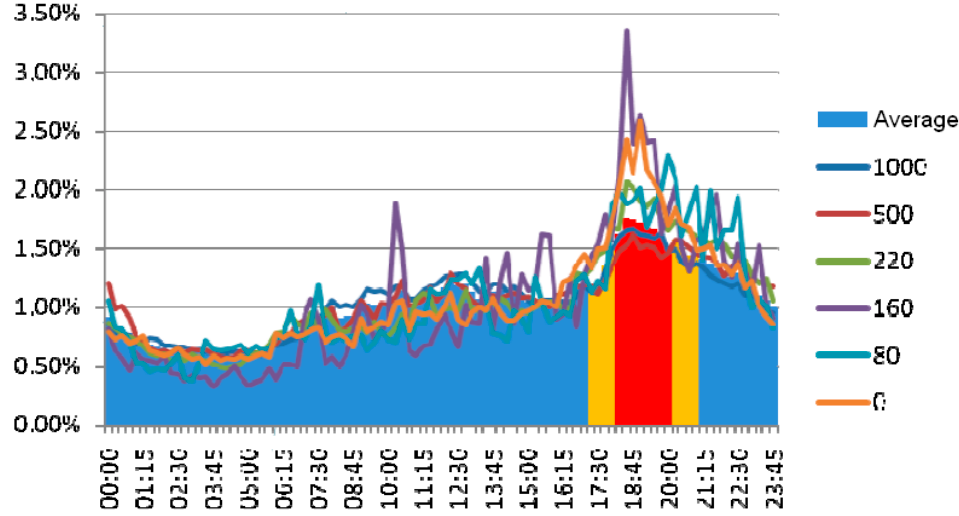
Figure 3. Charge curve of a typical residential consumer. Source: ANEEL [44].